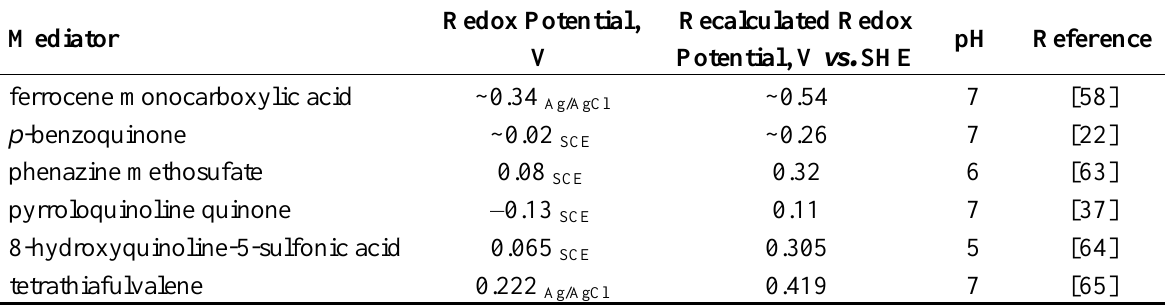
Table 3. Typical mediators for GOx-based glucose oxidation.